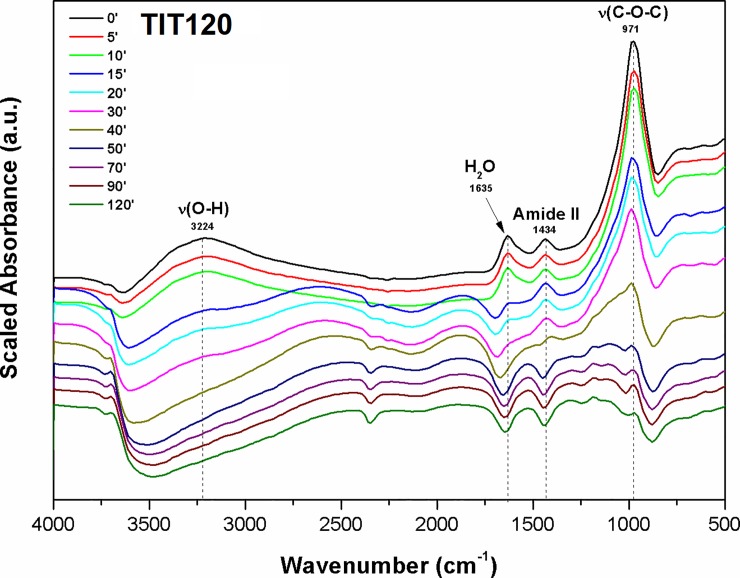
DRIFTS spectra of pirarubicin interaction with the TiO2 surface (TIT120).